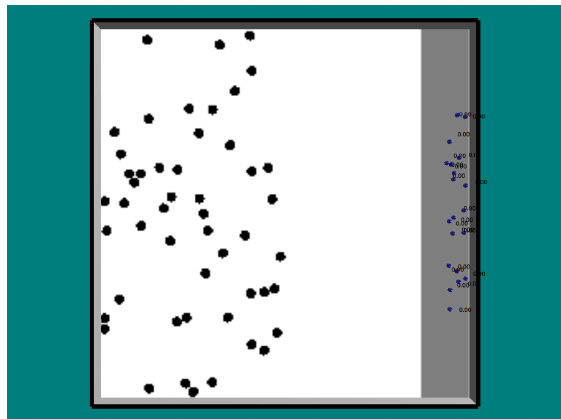
Figure 4. Screenshot of first simulated environment used. Food items are shown as black circles in the white environment, puck robots can be seen waiting in the nest area (light